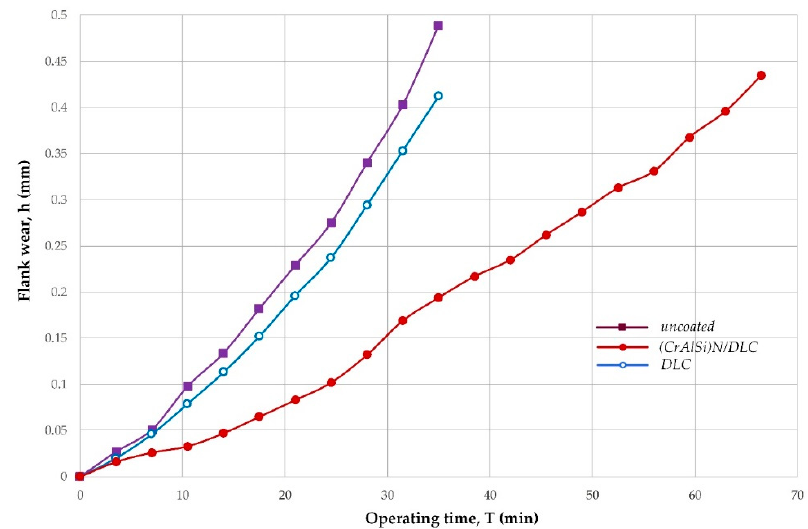
Figure 13. Dependences of the wear chamfer size on the flank surface of the end mills on the operating time when machining 41Cr4 structural steel with end mills with different coatings.